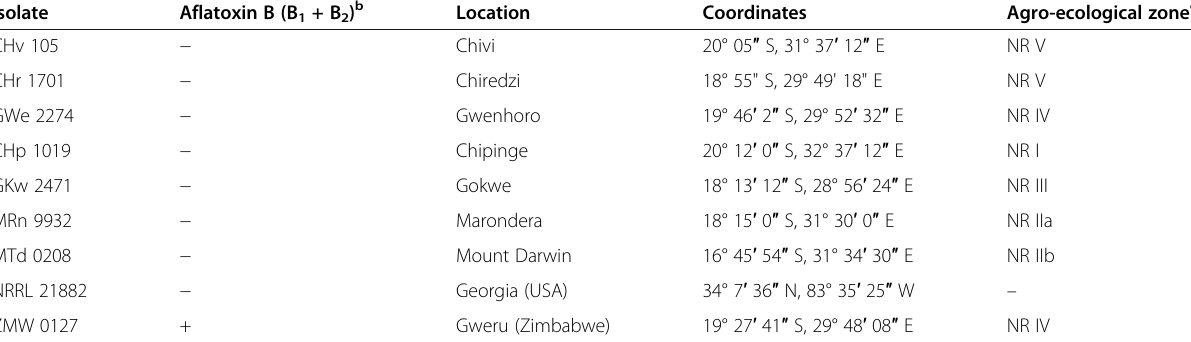
Table 1 Origins of isolates of Aspergillus flavus utilized in this current study native to Zimbabwe